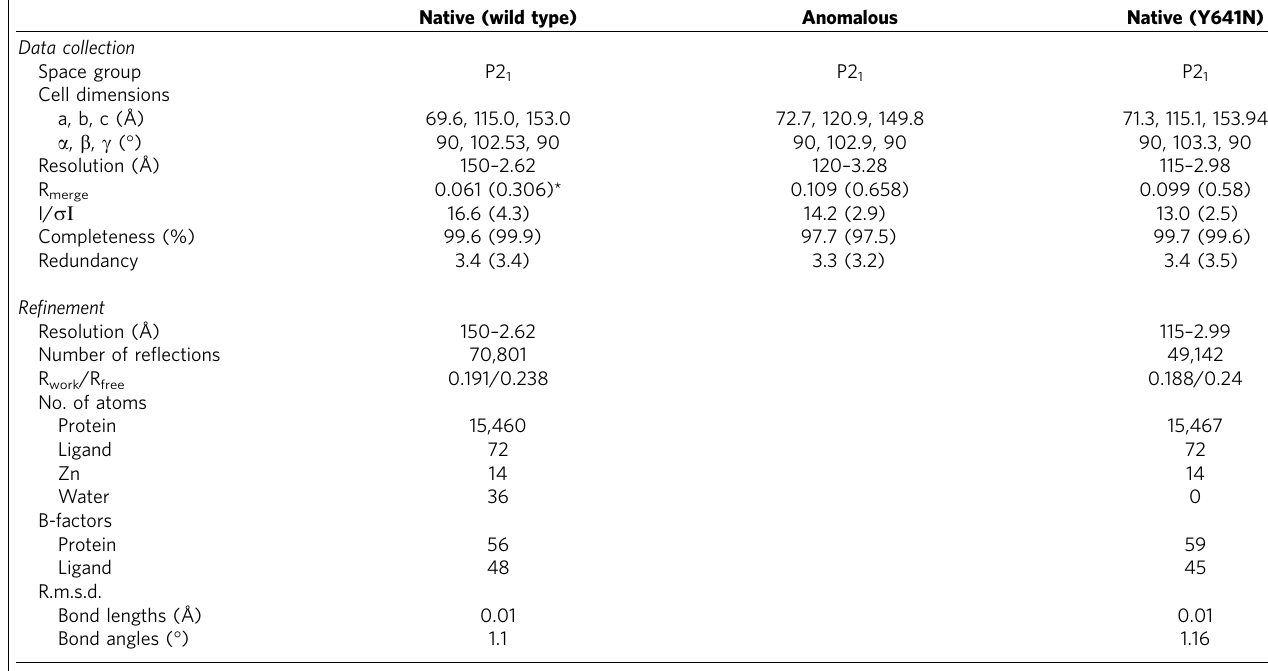
Table 2 | Data collection, phasing and refinement statistics